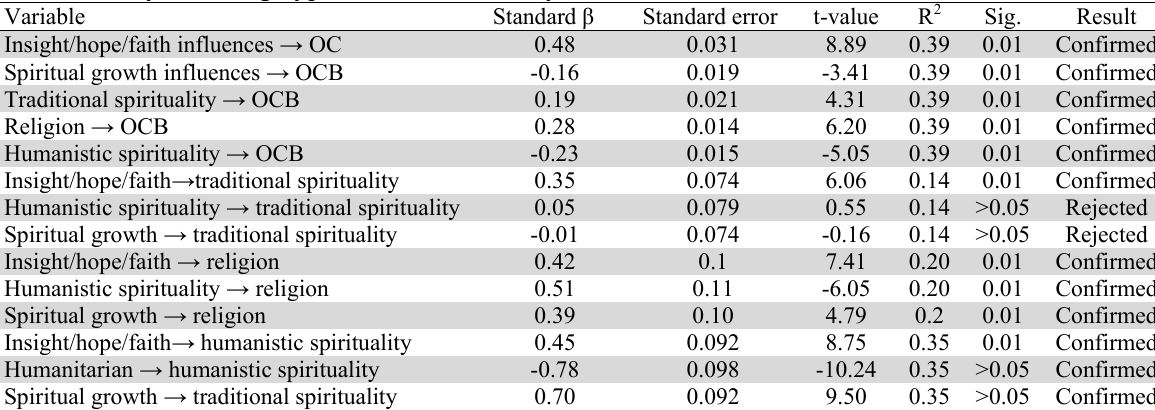
Variable Standard β Insight/hope/faith influences → OC Spiritual growth influences →